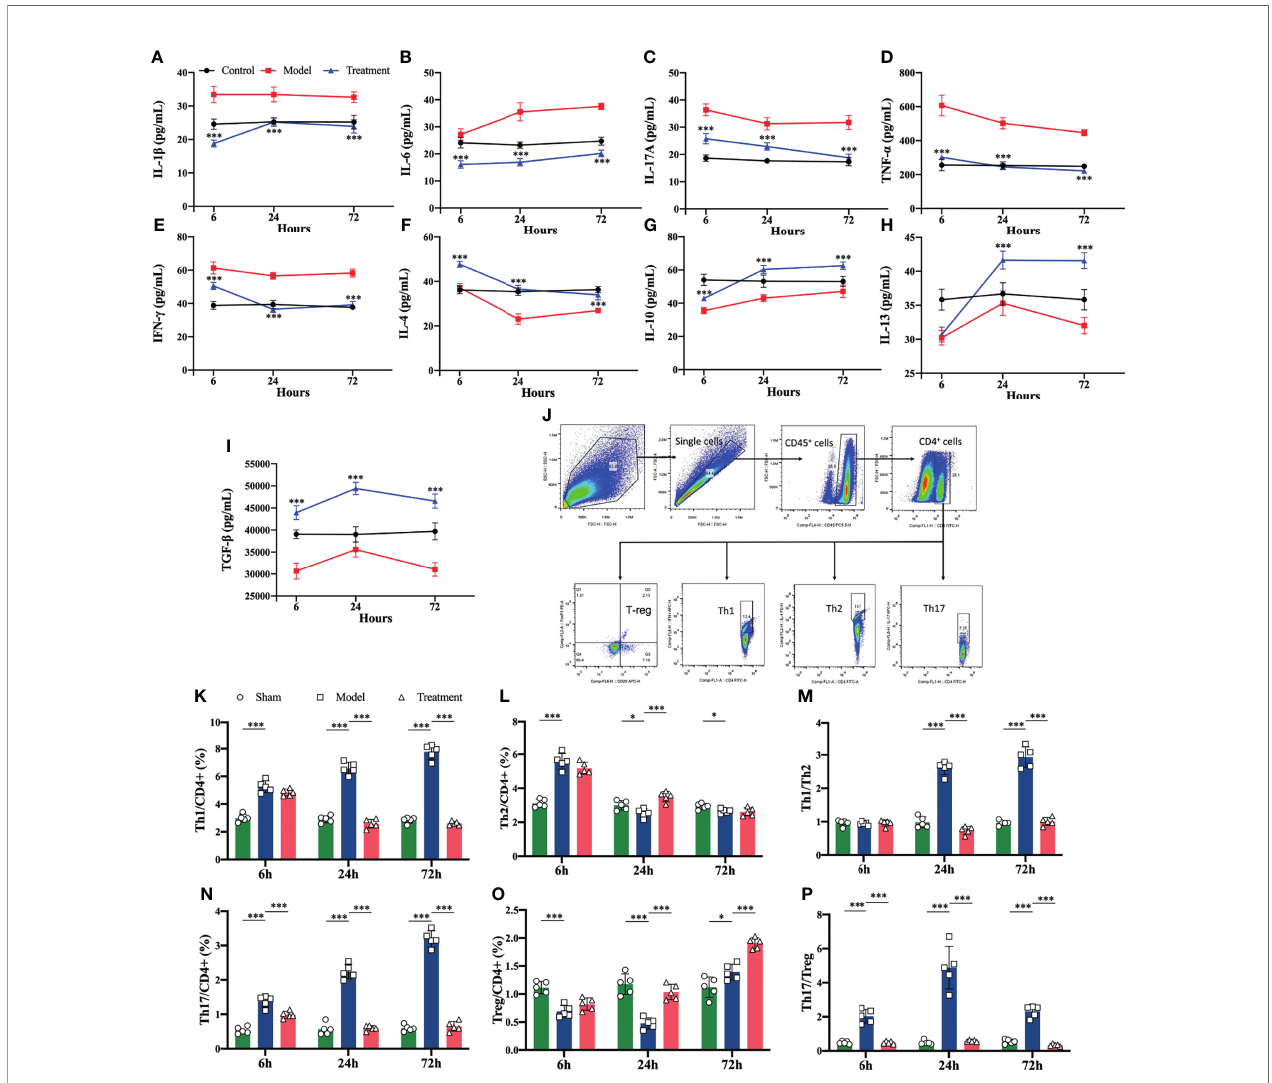
FIGURE 6 | Levels of in fl ammatory cytokines in cell supernatants and the proportion of Th cell subpopulations in lymphocytes in each group of in vitro experiments. Lymphocytes isolated from the spleen were co-cultured with MSCs at a ratio of 10:1, and the lymphocytes and supernatants were analyzed at 6h, 24h and 72h, respectively. (A – I) Levels of in fl ammatory cytokines in cell supernatants of each group (*compared with the model group); (J) circle gating strategy for fl ow cytometry analysis of the proportion of Th cells in lymphocytes of each group; (K, L, N, O) fl ow analysis of the proportion of Th1, Th2, Th17, and Treg cells in lymphocytes of each group as a percentage of CD4 + T cells; (M) ratio of Th1/Th2 in lymphocytes of each experimental group; (P) ratio of Th17/Treg in lymphocytes of each experimental group. n=5, *p<0.05,